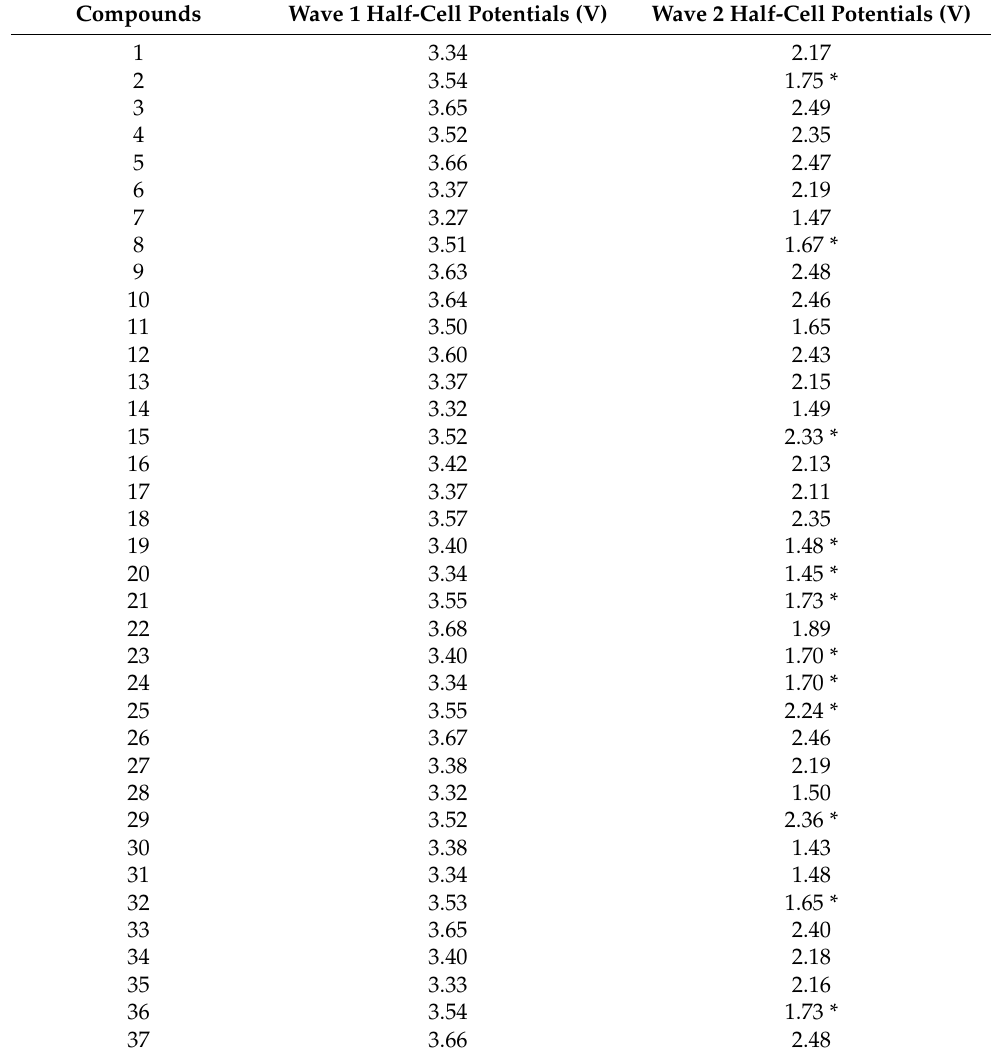
Table 2. The predicted half-cell reduction potentials for the 1,4-di-N-oxide quinoxaline-2-carboxamide derivatives calculated using Gaussian 09 at the DFT: B3LYP/lanl2dz level of theory [32,37]. Compounds Wave 1 Half-Cell Potentials